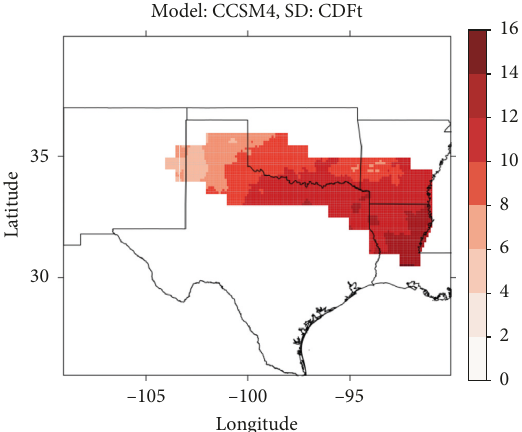
Figure 6: Difference fields for mean daily minimum temperature ( ° C) for the historical (1981–2005) time frame for CCSM4. Dark shades of red represent higher minimum temperature